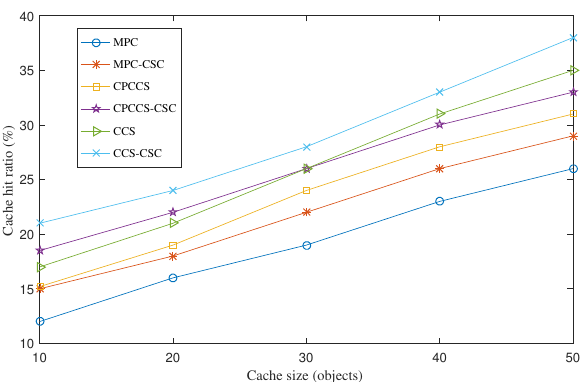
Figure 1. Average cache hit ratio of MPC, MPC-CSC, CPCCS, CPCCS-CSC, CCS, and CCS-CSC under various cache